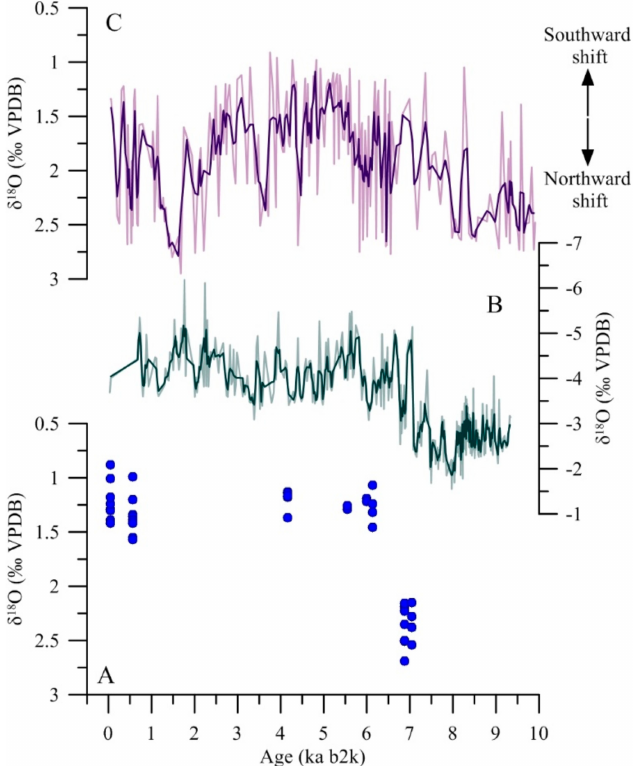
Figure 5. ( A ) Oxygen isotope records from this work plotted against isotopic composition of G. inflata [4] in the Brazilian and Falkland confluence zone ( C ) and oxygen isotopic composition of carbonates from laguna Potro Aike ( B )